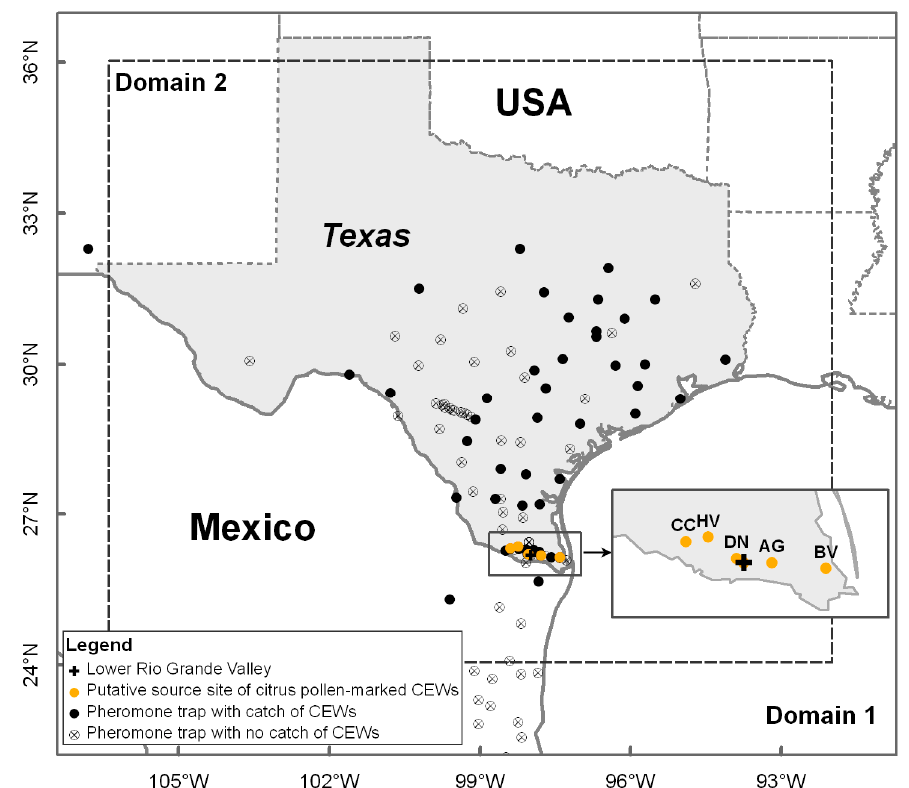
Figure 1. Locations of pheromone traps and occurrence of H. zea migrants (CEWs). Rectangle frame indicates locations in southern Texas with blooming citrus recorded in historical data and regarded as source sites in this study, comprising Adams Garden (AG), Bay View (BV), Citrus City (CC), Donna (DN) and Heald Valley (HV).